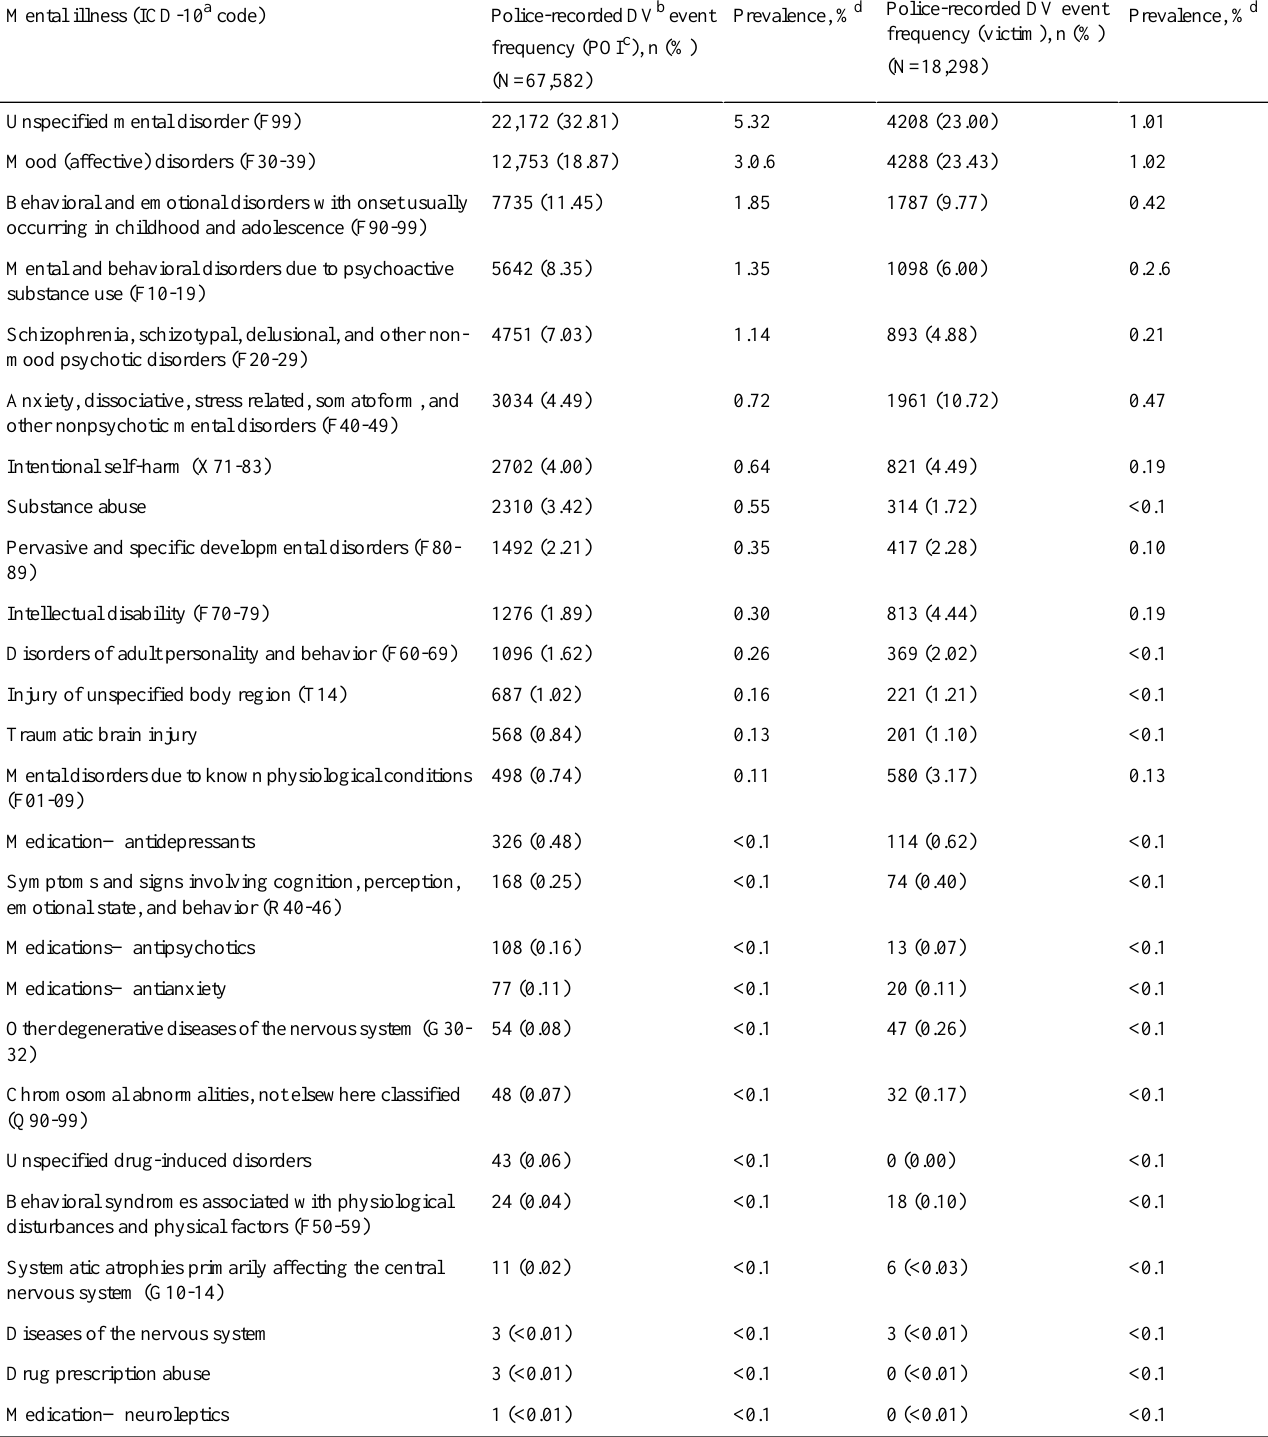
Table 2. Number of police-recorded DV events (%) with a mental illness mention grouped by the first ICD-10 level for POIs and victims from 416,441 DV events recorded by the New South Wales Police Force in Australia between 2005 and